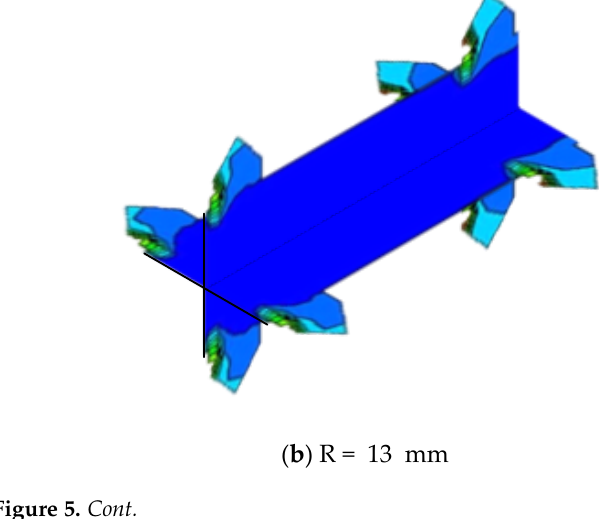
Figure 4. Streamlines for various configurations of Case A with different R parameters at A 2 = 24 mm, Re = 15,000, and 𝜑 = 0.5%.